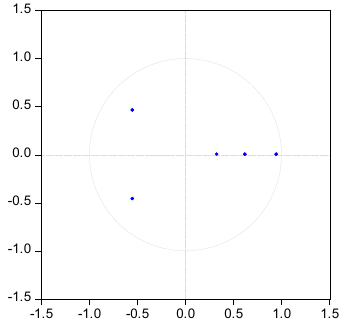
Figure 6. VAR roots of characteristic polynomial of mining and processing of ferrous metal ores. Note: blue dots indicate characteristic roots.